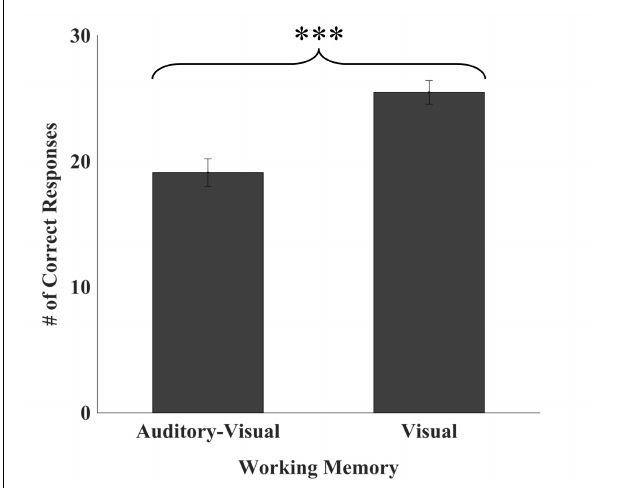
FIGURE 1 | Number of auditory-visual versus visual working memory items recalled. High-performing CI users recalled significantly more visually presented items relative to auditory-visually presented items. Error bars represent 95% confidence intervals. ∗∗∗ p <